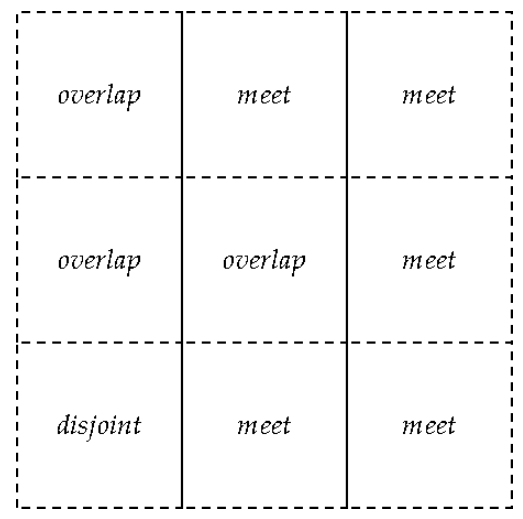
Figure 12: Test case to demonstrate the application of Rules